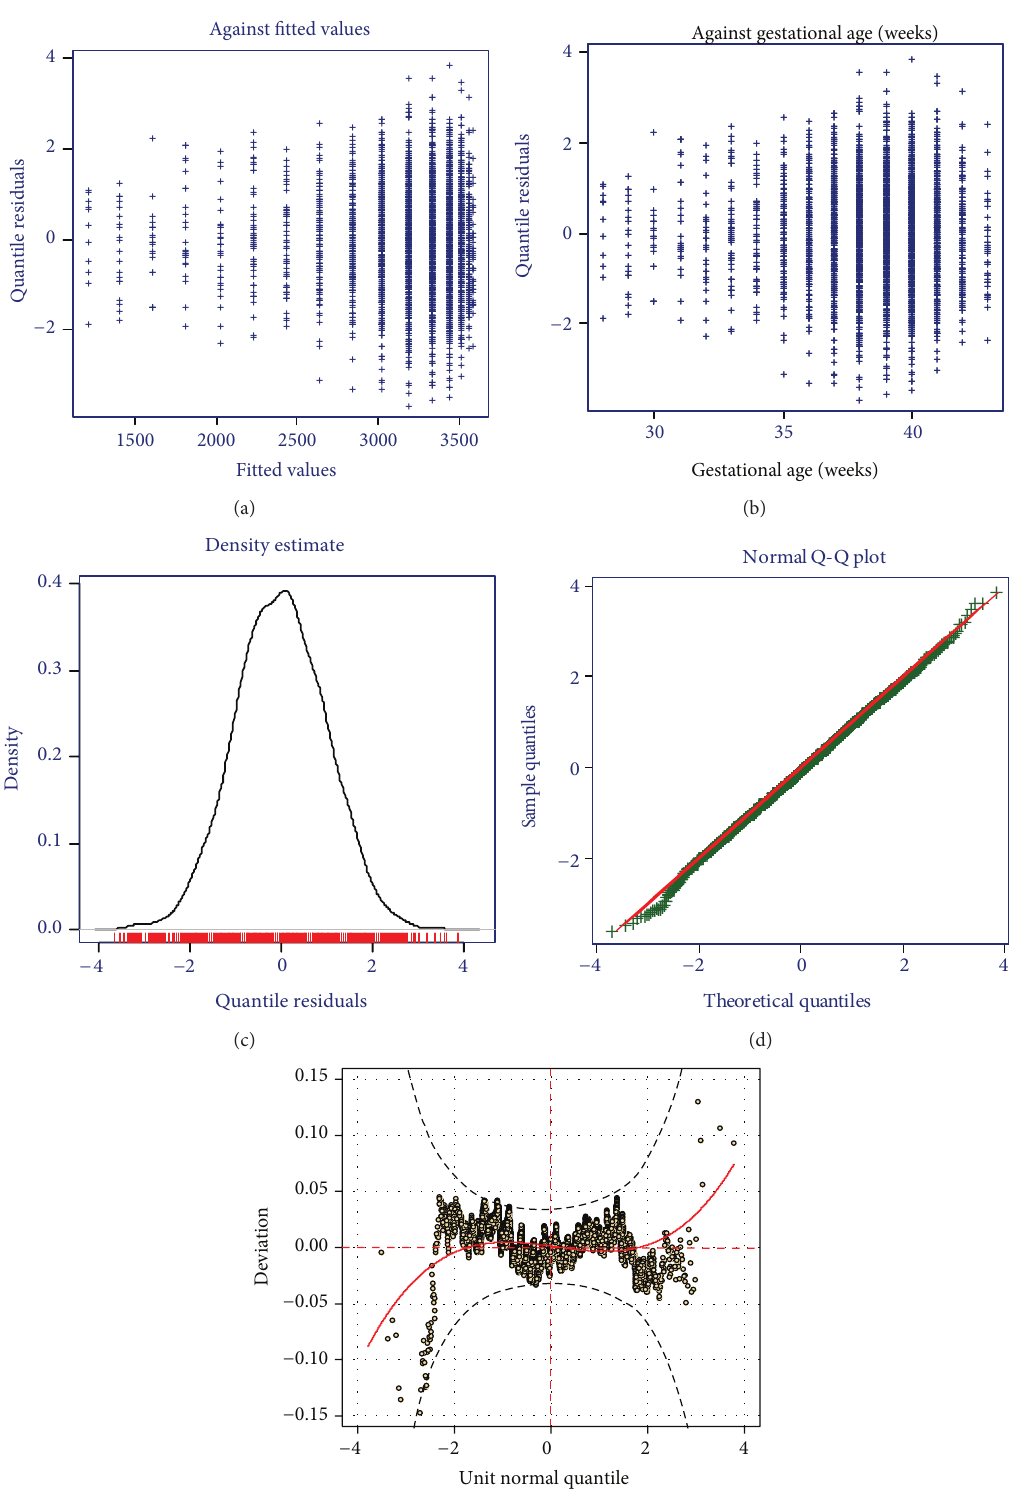
Figure 2: Residual and worm plots of birth weights of female Cameroonian